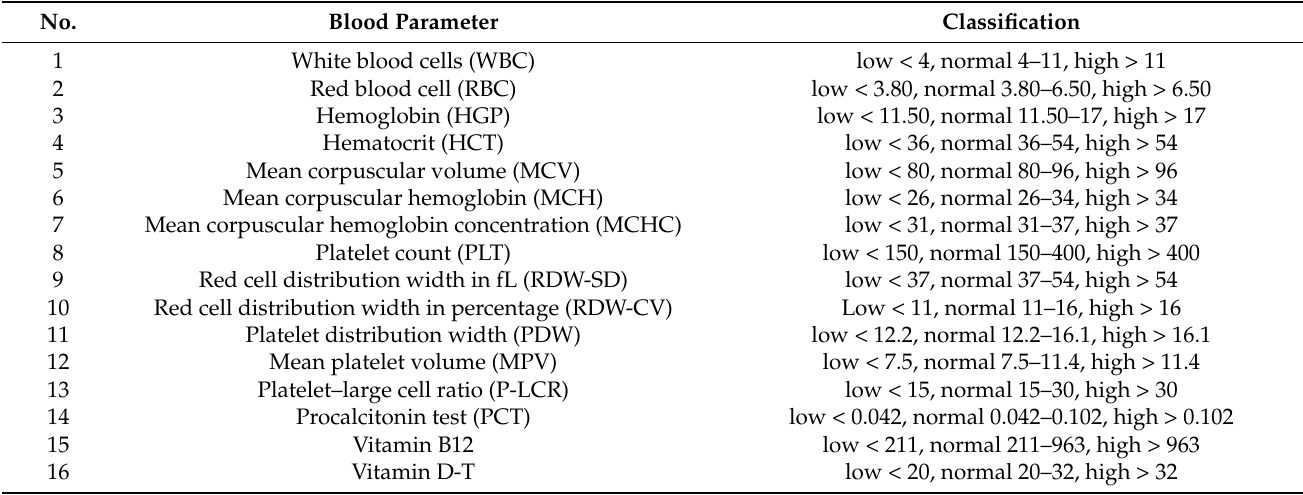
Table 1. Blood parameter and test results